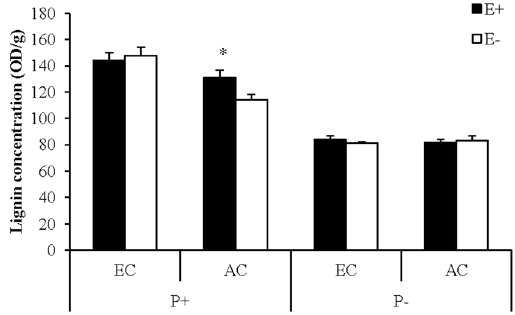
Figure 8. Lignin concentration of endophyte-infected (E + ) or uninfected (E − ) Festuca arundinacea under different CO 2 concentration (EC, 800 ppm; AC, 400 ppm), and pathogen inoculation (P + , inoculated by Curvularia lunata ; P − , uninoculated control). * Meant significant difference at 0.05